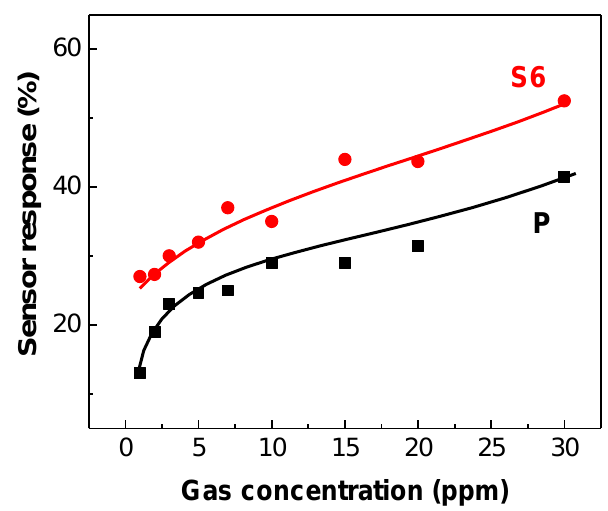
Figure 11. Variation in sensor response (%) as a function of NO 2 concentration recorded for both pure and Zn-doped CuO films at 150 °C.